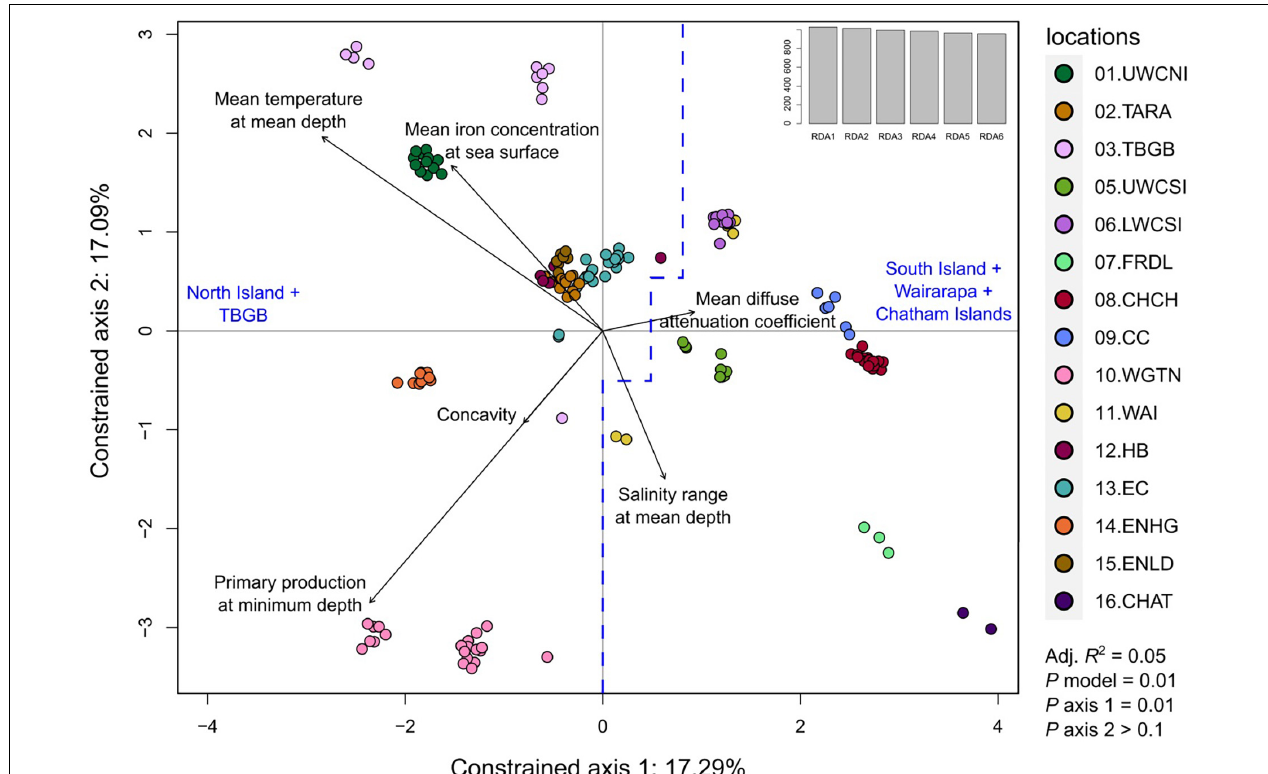
FIGURE 10 | Redundancy analysis (RDA) performed on the quality-filtered SNP dataset from scaffold 1, restricted to adult tarakihi from New Zealand. This included 108,903 loci from 156 tarakihi. The two constrained axes show samples from 16 localities in relation to six lowly correlated environmental variables (black arrows). All samples on the left of the blue dashed line are from North Island and Tasman Bay/Golden Bay, while all samples on the right are from South Island, Wairarapa and Chatham Islands. Top right: Eigenvalues. Sampling location codes as referred to in Table 1